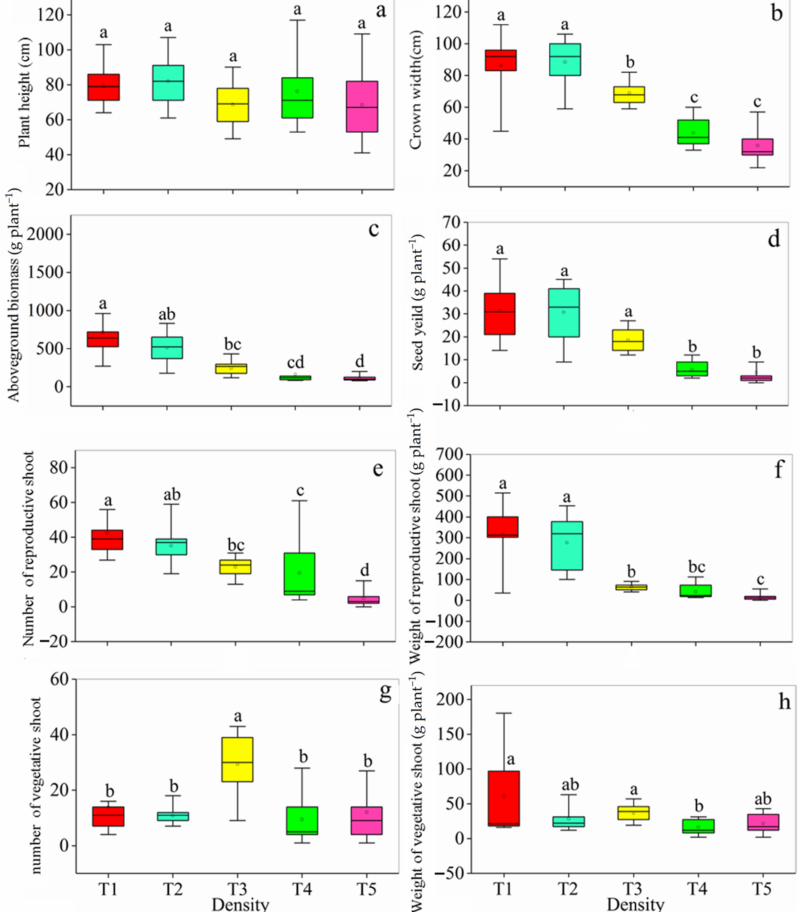
Figure 1. The box treatments of plant growth characteristics include height ( a ), crown width ( b ), aboveground biomass ( c ), seed yield ( d ), number and weight of reproductive shoot ( e , f ), and number and weight of vegetative shoot ( g , h ). The different letters within each panel denote significant differences ( p < 0.05) among the five population densities. Abbreviations T1, T2, T3, T4, and T5 represent, respectively, the population density of 1.1, 2.1, 3.1, 3.9, and 5.3 seedlings per m 2 . The same applies to the figures